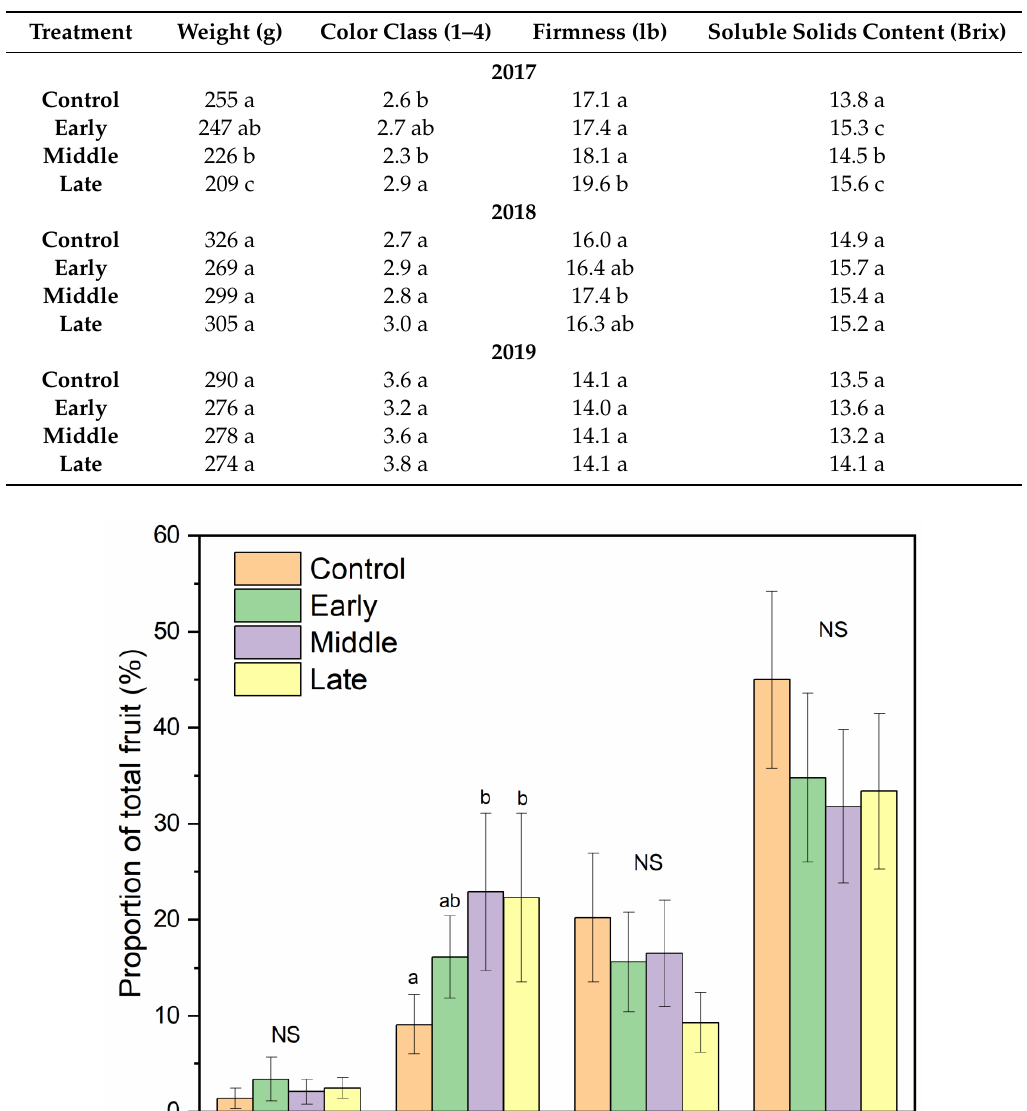
Table 1. Fruit quality after three months of storage in regular atmosphere at 1 °C for trees where early, middle, and late summer water deficits were applied compared to a well-watered control. Different letters denote significant differences within each year among treatments determined using a Fisher’s LSD test (α = 0.05).